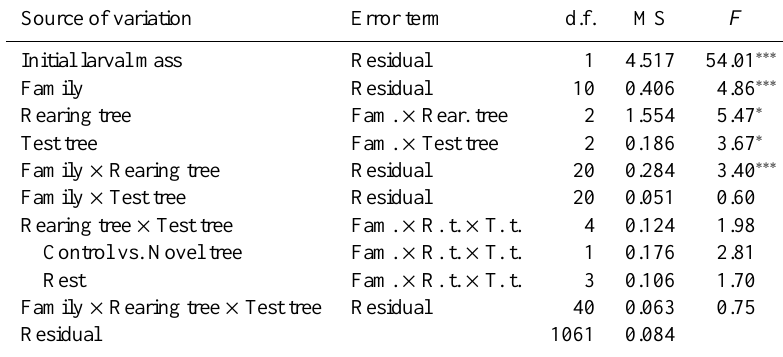
Table 1. The e ff ects of moth family, rearing tree individual and test tree individual on the final dry mass of the larvae of Lymantria dispar . Results of a general linear model with (log) initial larval mass as a covariate. Larvae were reared on leaves of one of three oak individuals and their growth was then tested feeding them leaves from the same or one of the other two trees (test trees). We partitioned the interaction rearing tree × test tree into a contrast that tests the e ff ect of transfer to leaves from a novel tree vs. the e ff ect of transfer to leaves from the same tree (control) and a